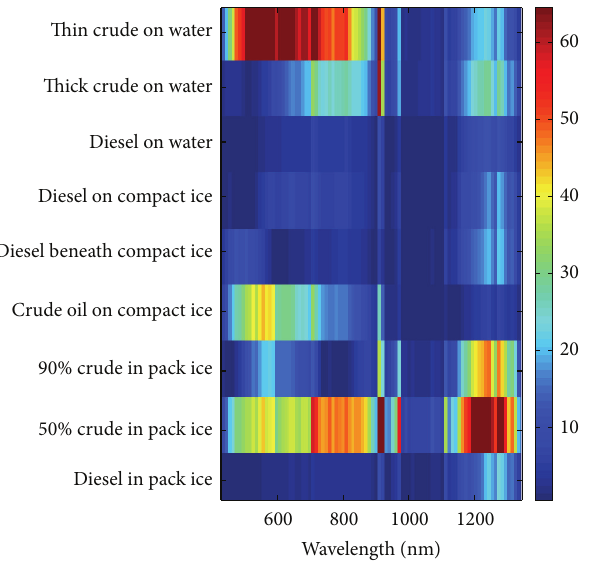
Figure 6: Difference of the 𝑁𝐸Δ𝑅 𝐸 value between oil and the uncontaminated water or